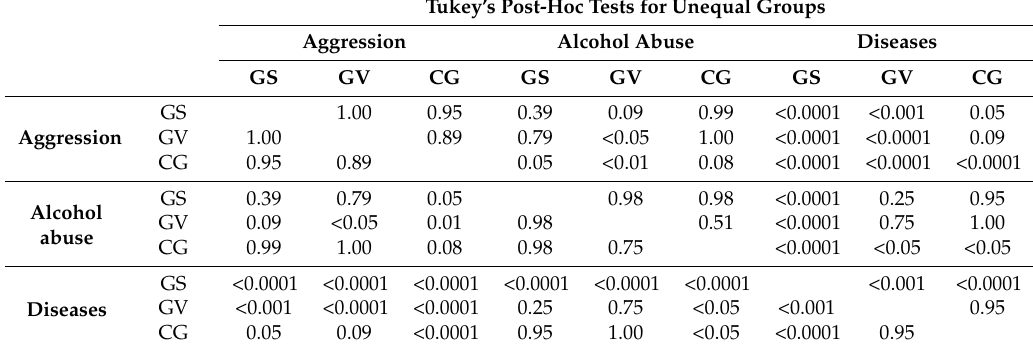
Table 2. Differences in Family Projections in the Studied Girls. Post-hoc Tukey’s tests for unequal